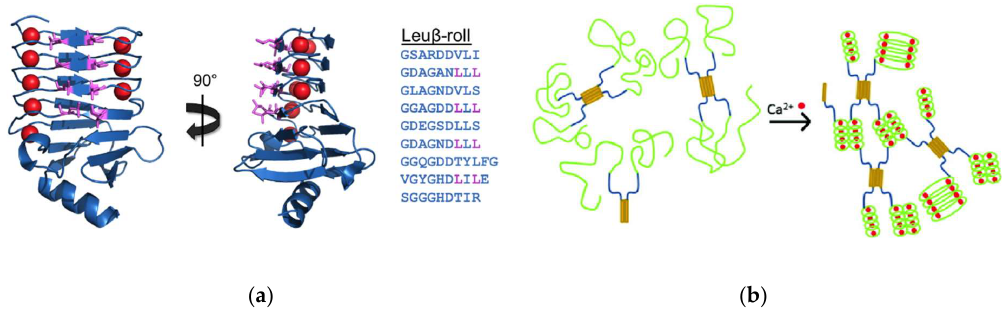
Figure 2. The Block V RTX domain as a hydrogel building block. ( a ) The positions on one β -sheet face have been mutated to hydrophobic leucine residues. The folded conformation of the Leu β -roll mutant is shown (PDB file: 5CVW) along with the peptide sequence of the β -sheet forming residues, whereby the mutated positions are shown in purple. ( b ) The Leu β -roll (green) has been fused to an α -helical leucine zipper domain (yellow) separated by a soluble linker (blue). The β-rolls fold upon calcium binding resulting in additional cross-linking leading to network formation. Adapted with permission